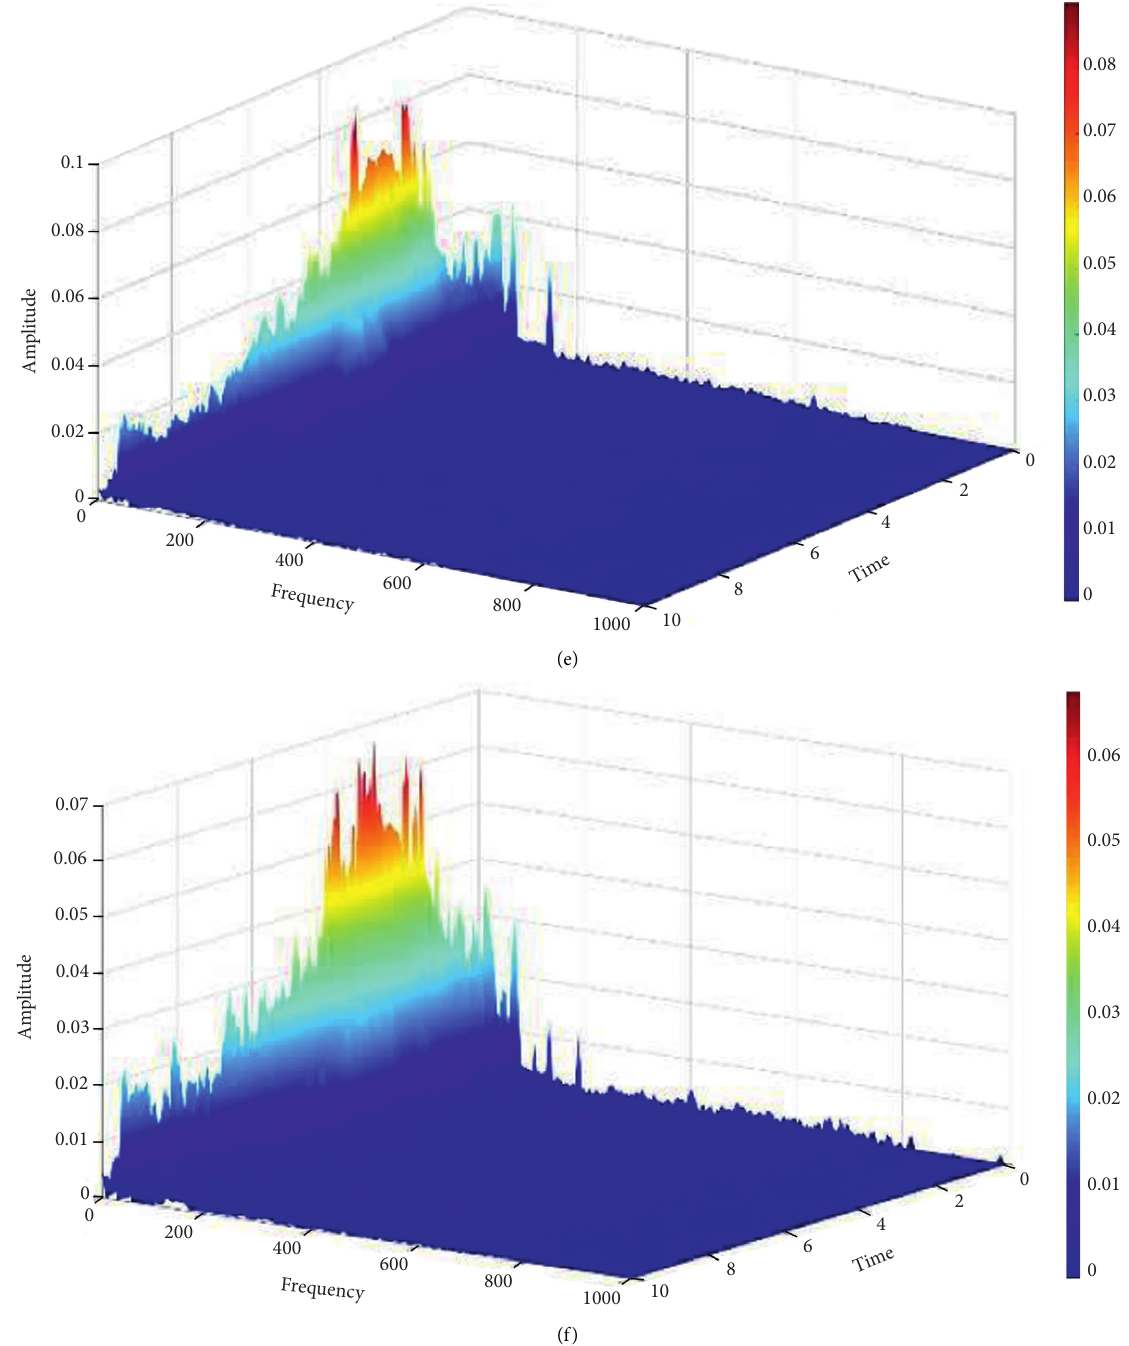
Figure 18: Hilbert–Huang spectrums at points (a) #1, (b) #3, (c) #5, (d) #7, (e) #9, and (f)